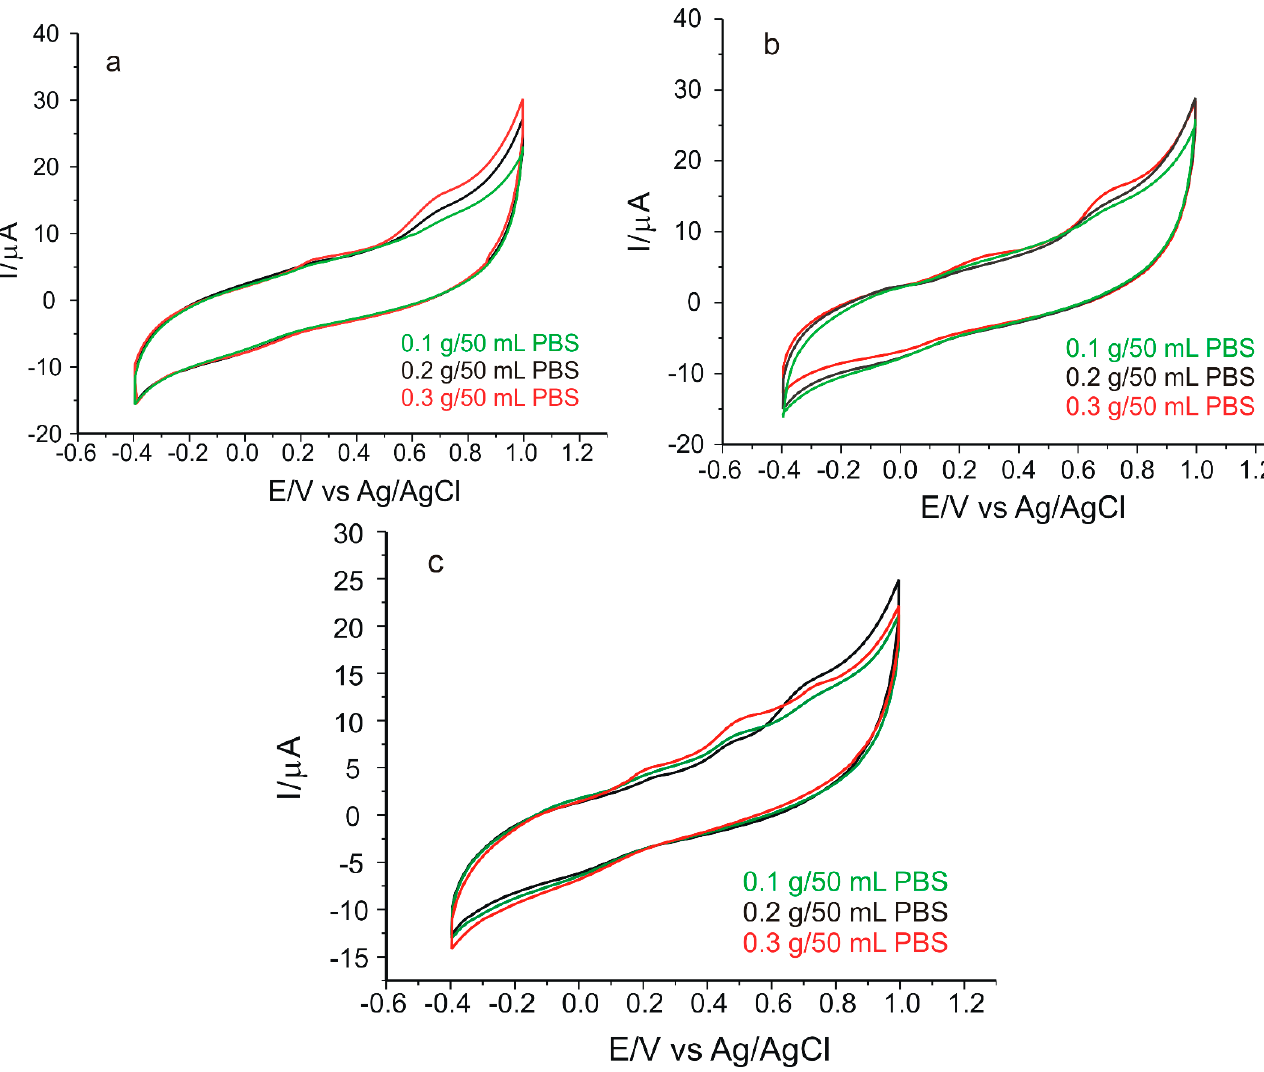
Figure 14. Cyclic voltammograms of GO-Peptide/SPCE immersed in solutions of ( a ) Apiterra anti- aging cream, ( b ) Sabio soothing and repairing balm, and ( c ) Vivanatura moisturizing mattifying cream of different concentrations. Scan rate: 0.05 V·s − 1 .